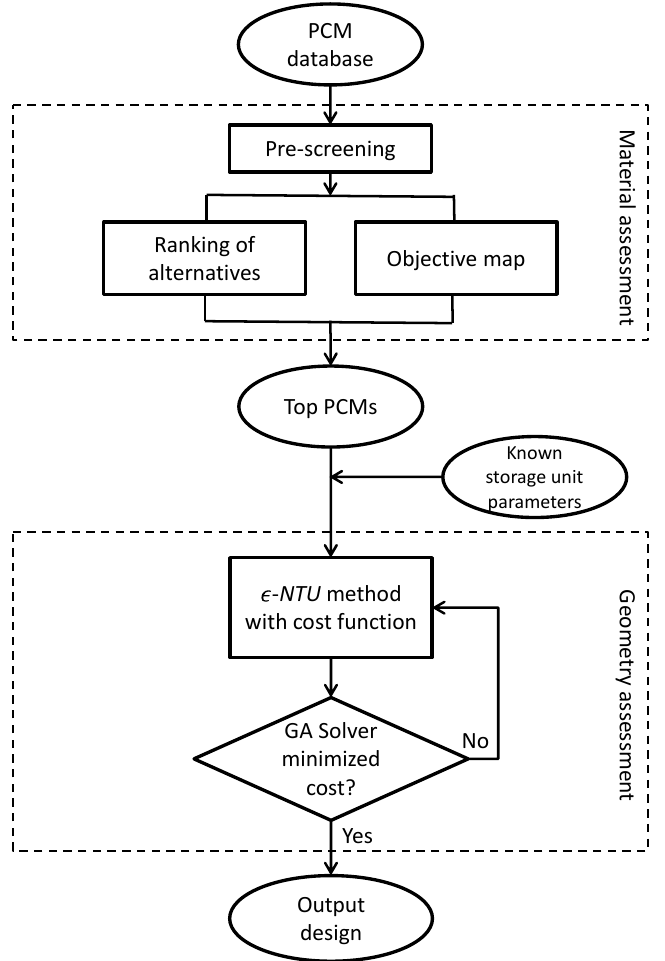
Figure 2. The workflow of the optimization methodology.